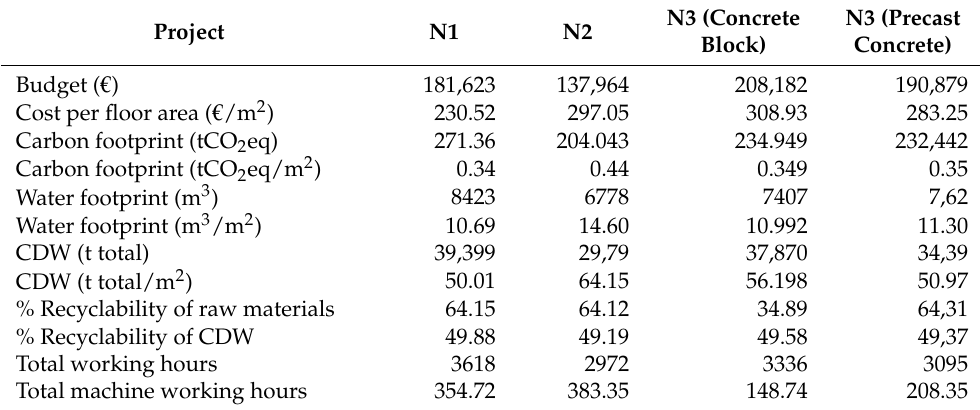
Table 6. Economic and environmental evaluation of the case